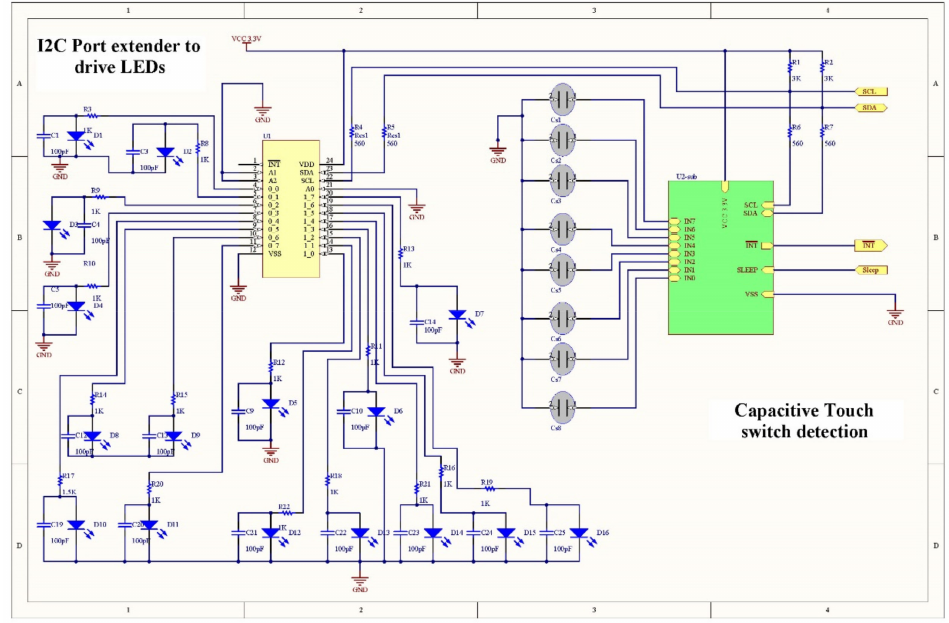
Figure A1. Digital switch and LED circuit diagram for textile